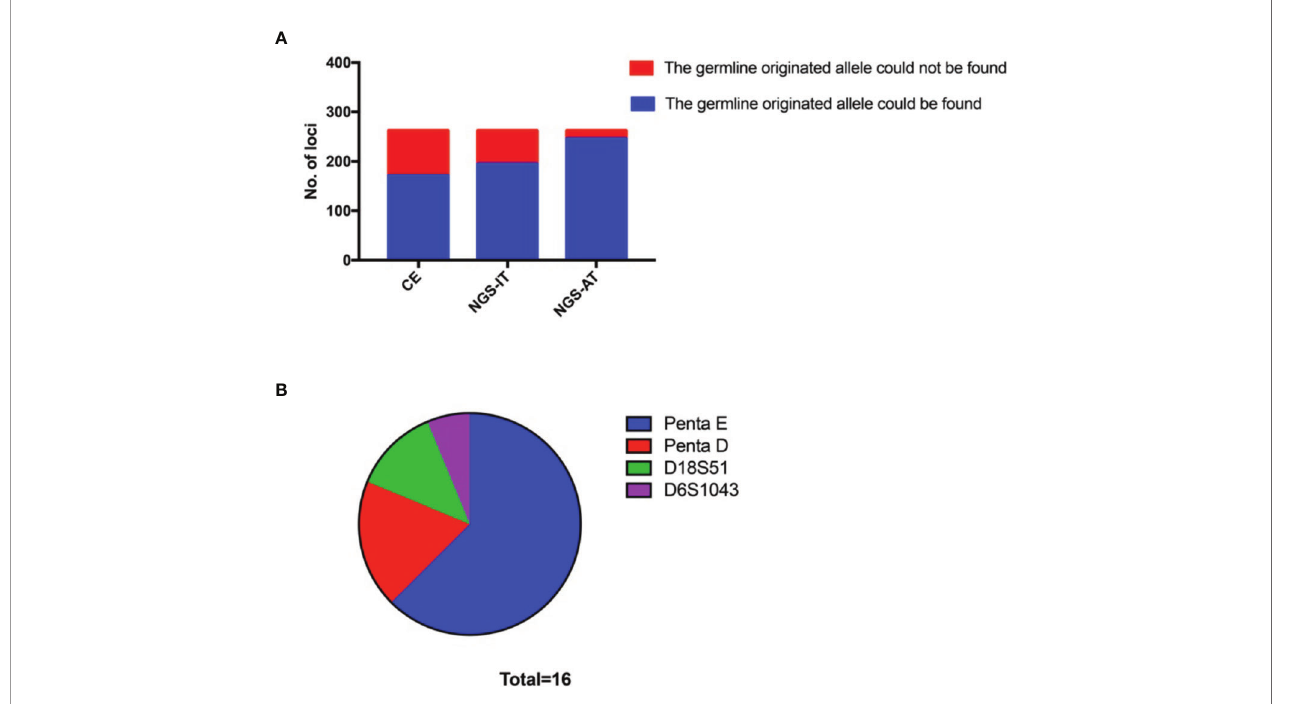
FIGURE 2 | More germline-originated alleles could be found by using an NGS-based platform. (A) Number of the germline-originated allele being detected in tumor samples by CE, NGS-IT, and NGS-AT. (B) Distribution of the loci whose germline-originated allele could not be found by NGS-AT. NGS, next-generation sequencing; CE, capillary electrophoresis; NGS-IT, NGS interpretation threshold; NGS-AT, NGS analytical